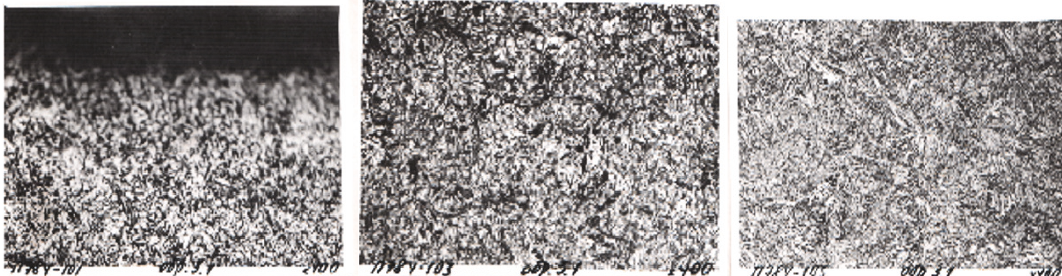
Figure 6: Microstructure of the reinforced layer and core (Sample 3.1). (a) near-surface zone; (b) effective area; (c) the core.